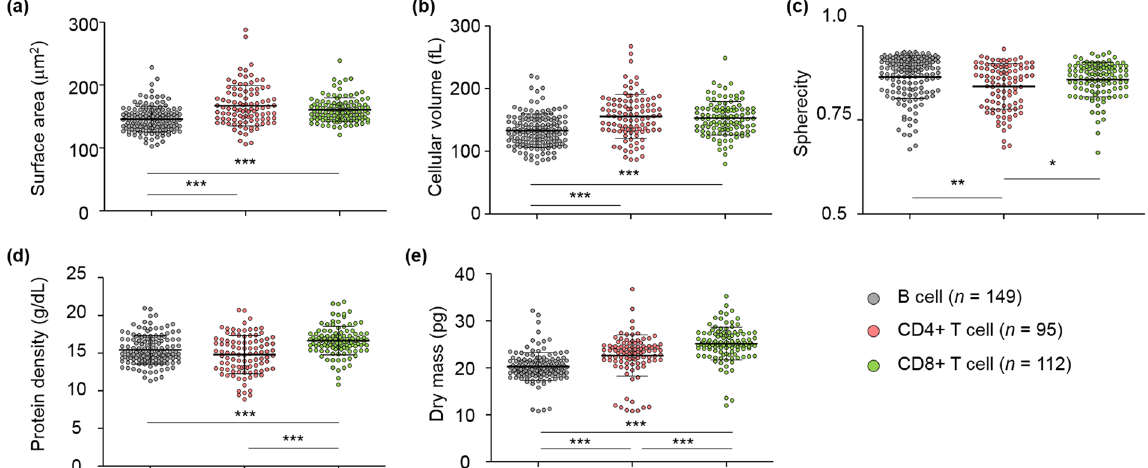
Figure 3. Quantitative analysis of the morphological and biochemical parameters of the individual B, CD4 + T, and CD8 + T cells. ( a – c ) The scatter plots of the morphological features: ( a ) surface area, ( b ) cell volume, and ( c ) sphericity. ( d , e ) The scatter plots of the biochemical features: ( d ) protein density and ( e ) dry mass. Each symbol indicates a single-cell measurement. Note that a single 3-D RI tomogram simultaneously provides all five parameters. Horizontal black lines, mean values; vertical lines with intervals, standard deviation. * P < 0.05; ** P < 0.01; *** P <